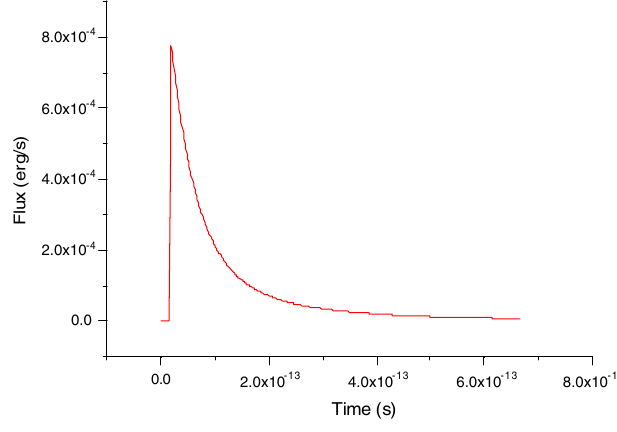
FIG. 7. (Color) Flux of the vector S as a function of